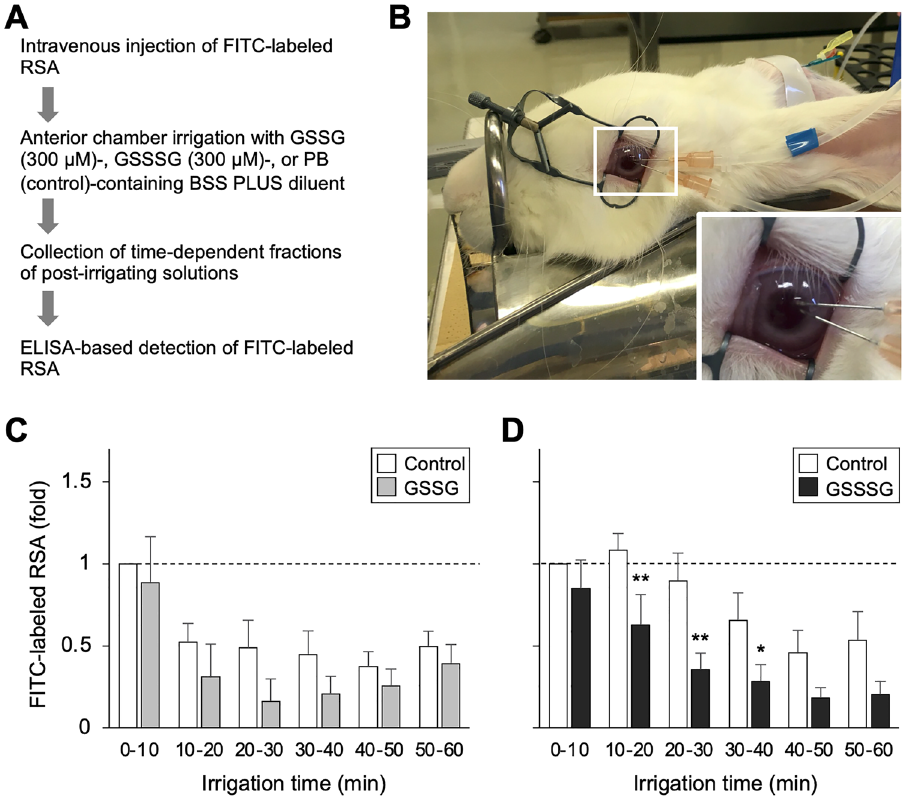
Figure 1. Effect of GSSSG on protection of the BAB. ( A ) Experimental procedure for quantification of BAB permeability. ( B ) Photographs of a rabbit undergoing anterior chamber irrigation. In the box, a close-up of the ocular area is shown. ( C , D ) ELISA-based quantification of FITC-labeled RSA in solution containing GSSG (300 µM) ( C ) or GSSSG (300 µM) ( D ) after perfusion in the anterior chamber. The concentration of FITC- labeled RSA in the solutions, collected at the shown irrigation time, is shown as a relative value to that in the control solution collected between 0 to 10 min during perfusion. Error bars indicate standard error of the mean. *P < 0.05 and **P < 0.01 (two-way repeated-measures ANOVA; n =